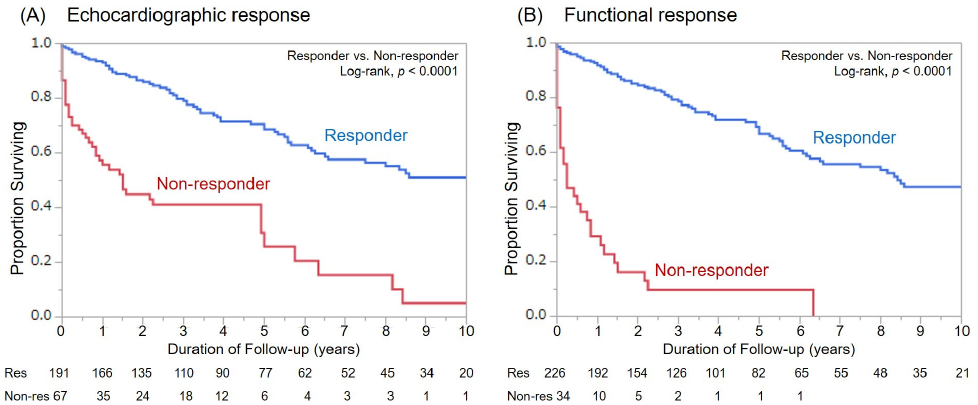
Figure 3. Kaplan–Meier curves for all-cause mortality among responders and non-responders based on both response definitions. ( A ): Echocardiographic response, ( B ): Functional